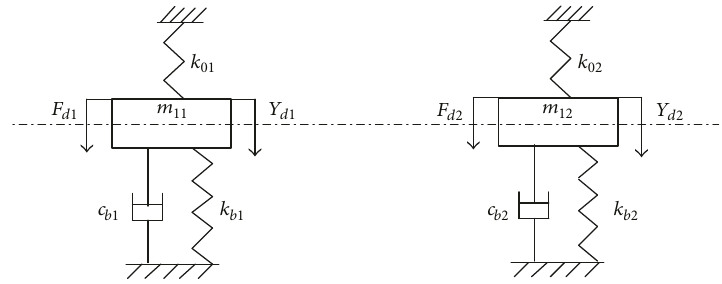
Figure 5: Mechanical model of bearing system.